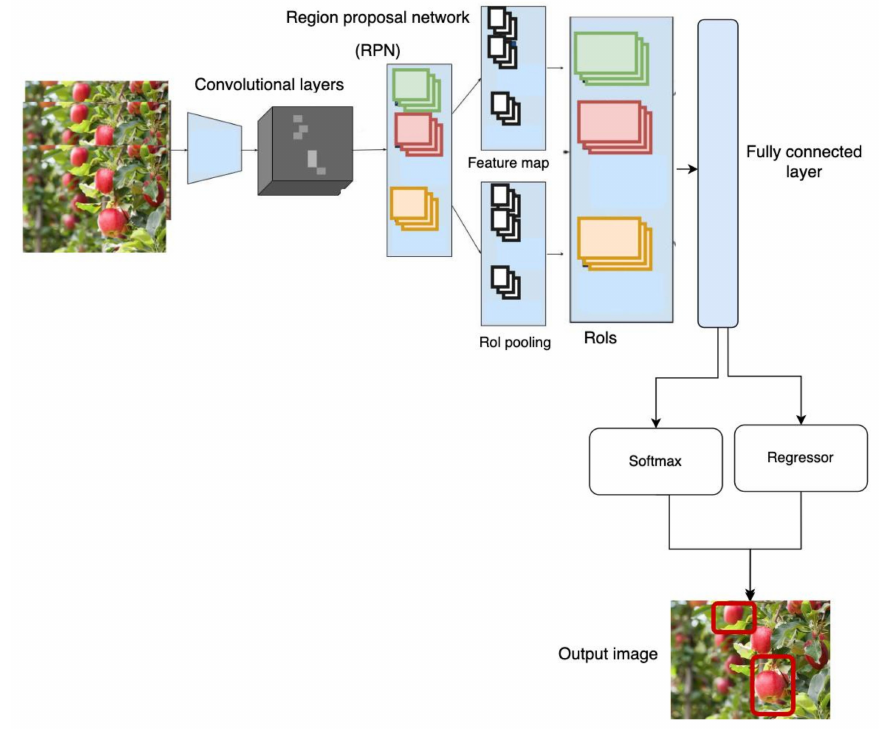
Figure 5. Flowchart for Faster R-CNN